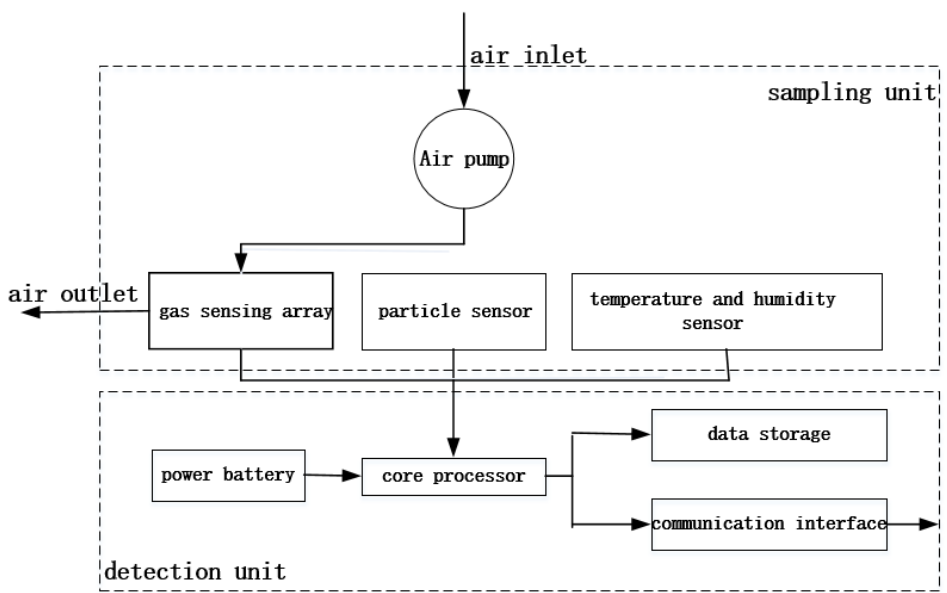
Figure 1. Hardware structure of monitoring terminal.